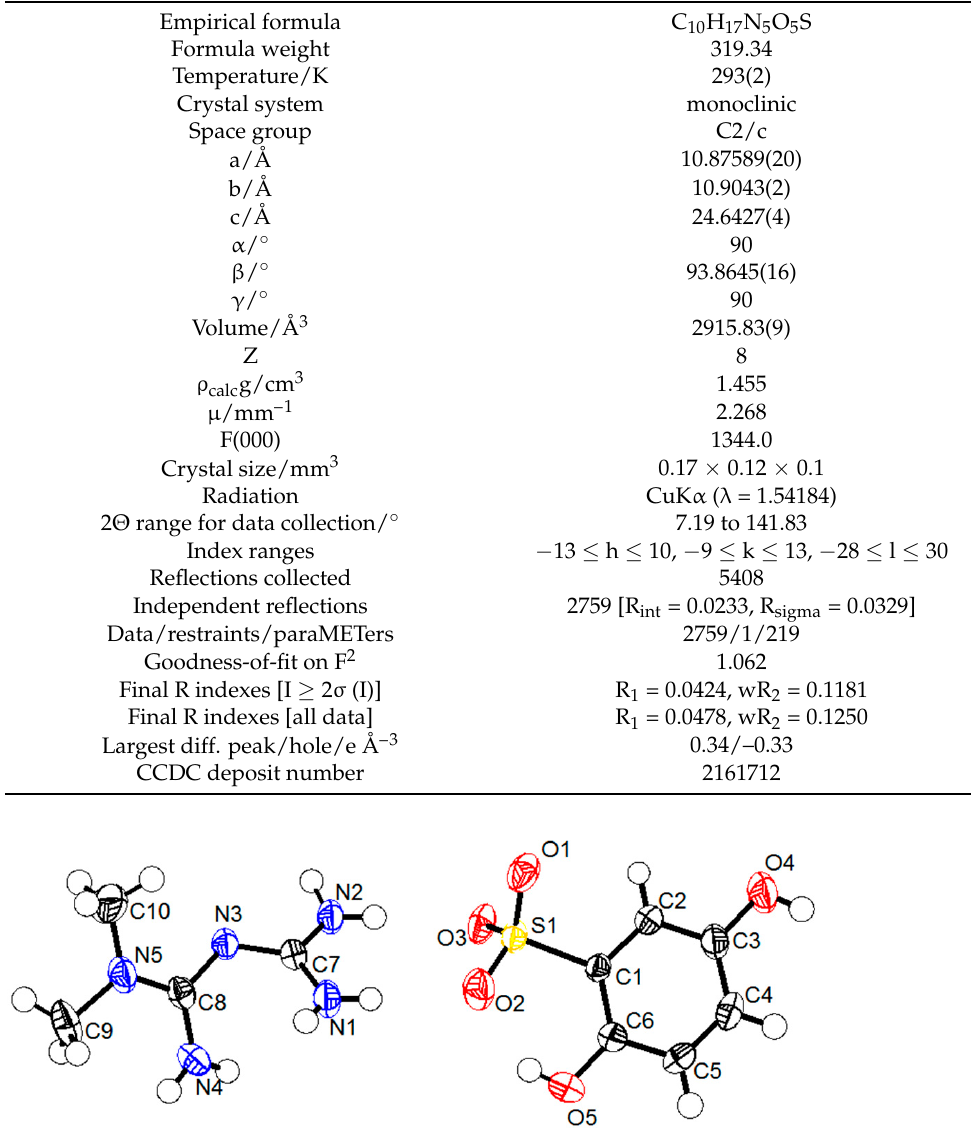
Table 1. Crystal data and structural refinement for MET–DBS.